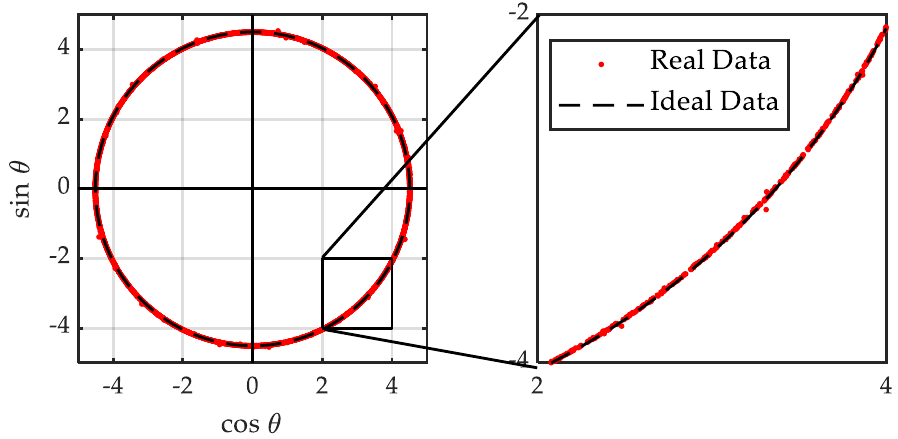
Figure 14. Sin-Cos sensor output signals.